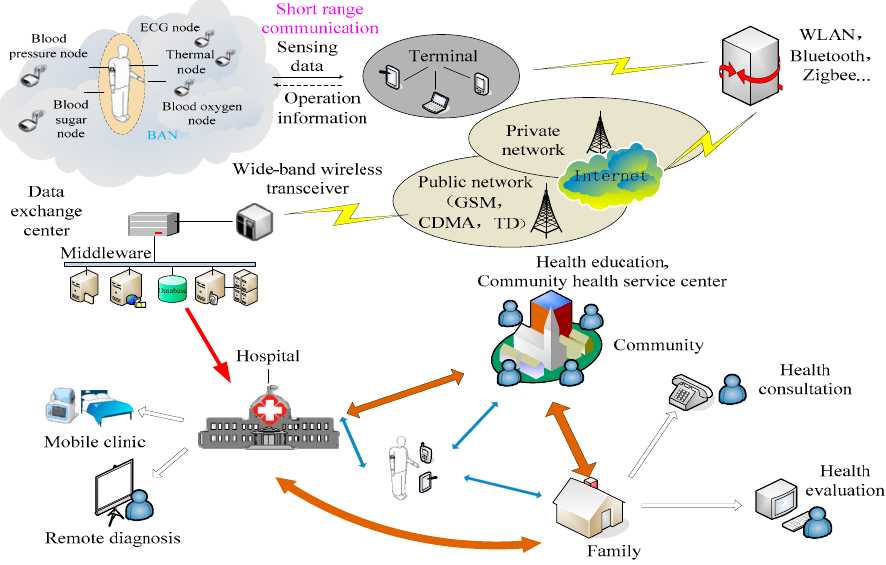
Figure 1. The basic idea of the WBAN system and its applications.